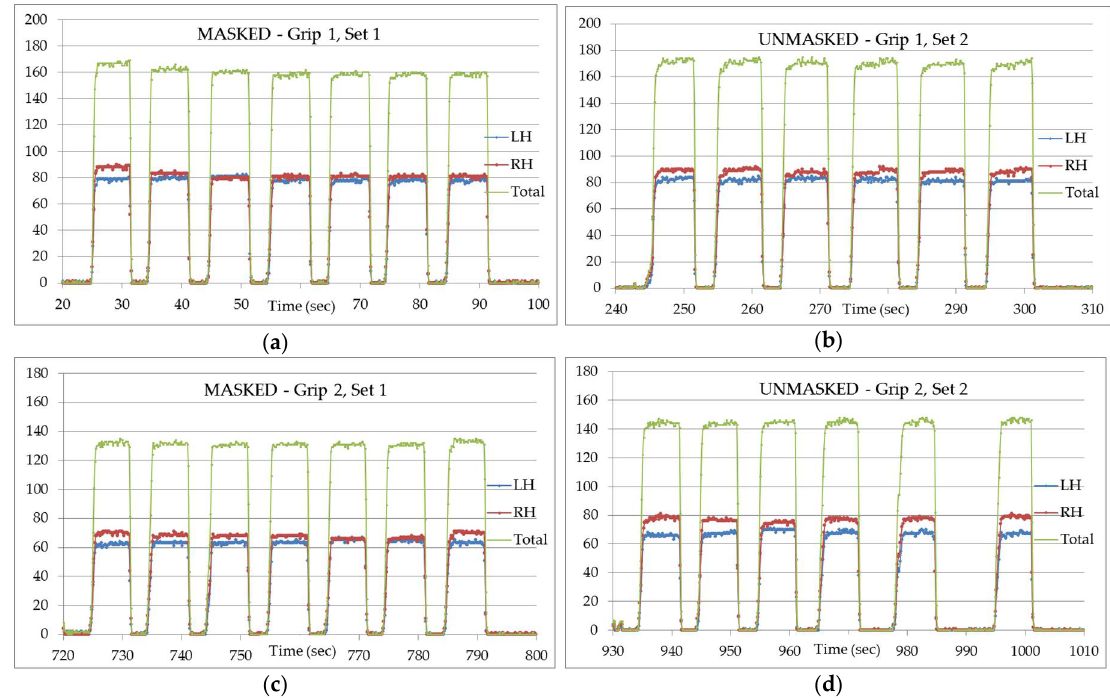
Figure 6. Exertion measurements for athlete 2. The ordinate axis is force, as in Figure 5. On the left, feedback to the athlete is masked—( a ) Grip 1, Set 1 and ( c ) Grip 2, Set 1. On the right, feedback to the athlete is unmasked—( b ) Grip 1, Set 2 and ( d ) Grip 2, Set